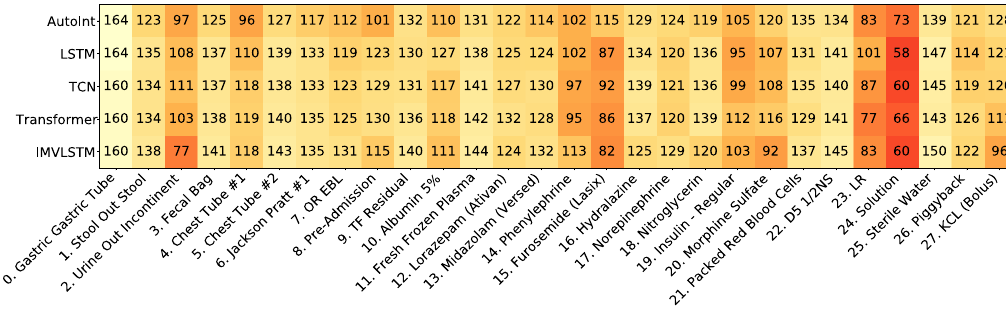
Figure 9. Visualization of global feature importance ranks (feature 0-27).